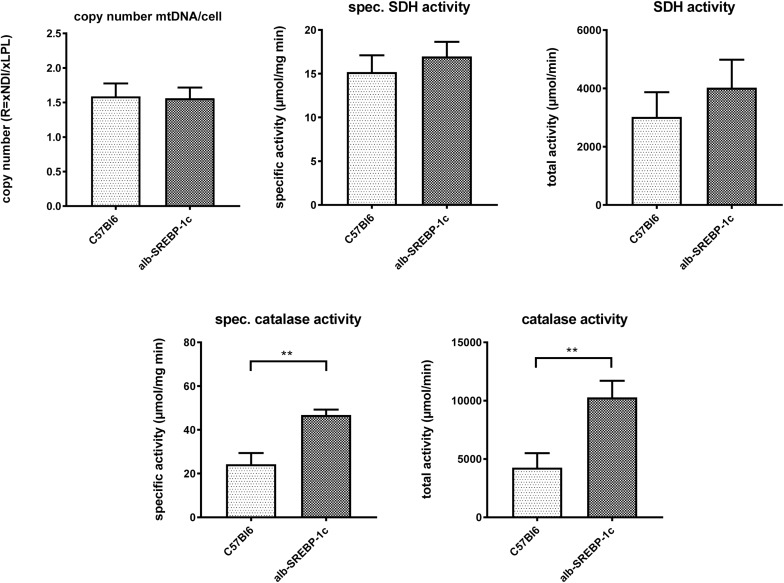
Mitochondrial DNA contend and marker enzyme activity of mitochondria and peroxisomes. The mtDNA content was determined in comparison to gDNA in C57Bl6 and alb-SREBP-1c mice (n = 20). Specific enzyme activities per mg liver tissue and total enzyme activities of mitochondrial succinate dehydrogenase (SDH) and peroxisomal catalase were determined in liver homogenates C57Bl6 and alb-SREBP-1c mice (n = 20) (n.s., not significant, ∗∗p < 0.01).